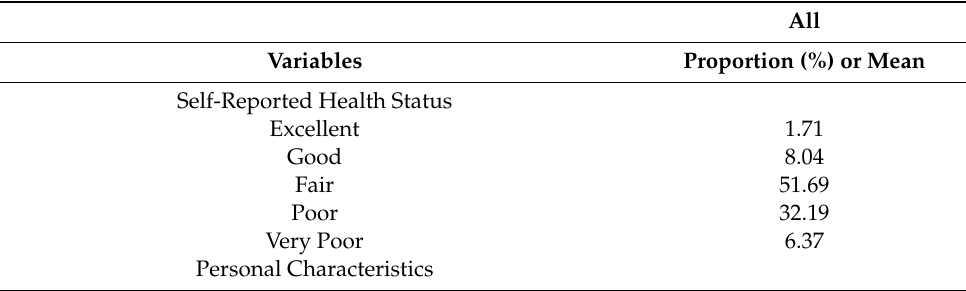
Table 1. Characteristics of the study